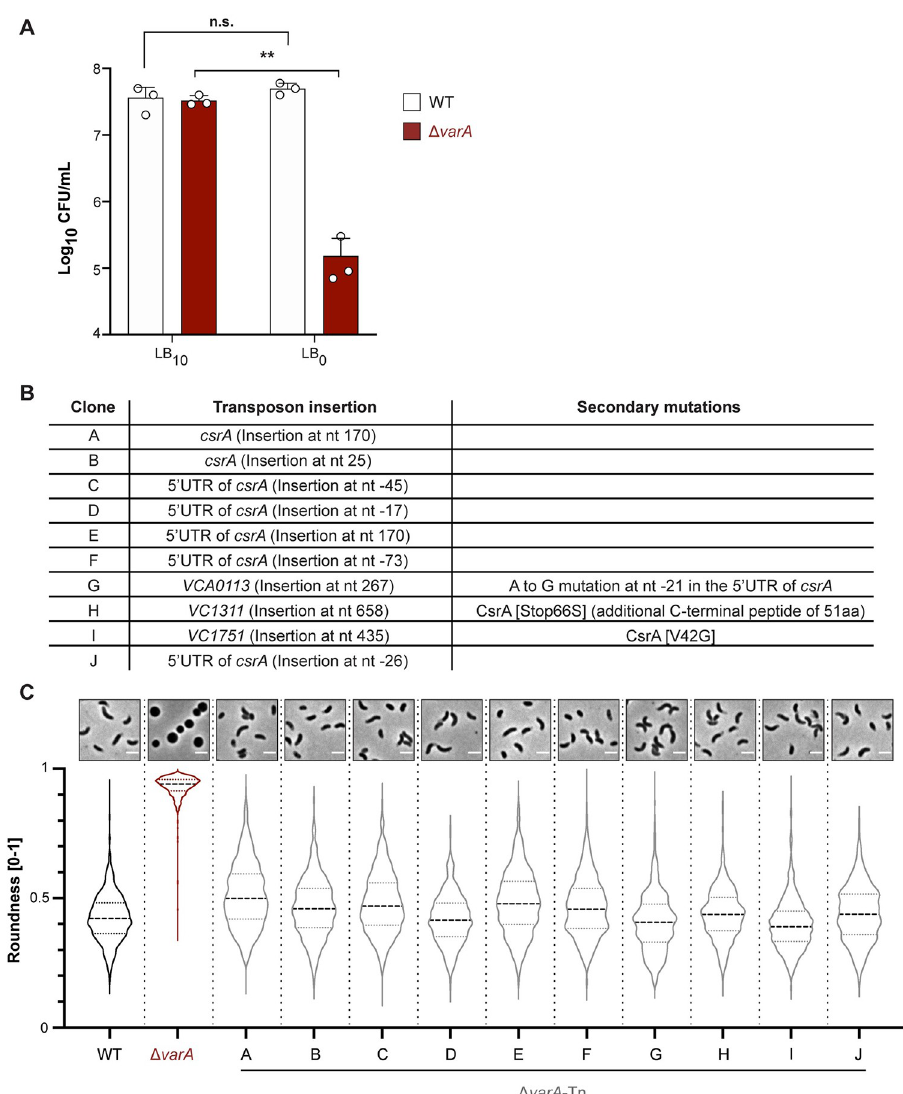
Fig 4. Suppressor mutants of Δ varA are linked to csrA . (A) Late growth Δ varA cells are sensitive to low osmolarity medium. After 20 h of growth, WT and Δ varA bacteria were diluted 1:100 in regular LB 10 or salt-free LB 0 medium for 1 h before further dilution and plating to enumerate CFUs on the next day. Bars represent the mean of three independent repeats; error bars show the standard deviation (S.D.) Log-transformed data were used for statistical analysis, which were based on unpaired t tests with Welch’s correction. �� , P < 0.01; n.s., not significant. (B) Summary of transposon hits. LB 0 -surviving mutants were isolated from the Δ varA -Tn transposon library, and the transposon insertion sites were determined. Information for 10 different mutants is provided. (C) Suppressor mutants restored the Vibrio cell shape. Phase contrast micrographs (top) and roundness quantification (bottom) of the WT, Δ varA , and the ten Δ varA -Tn suppressor mutants (A-J). Cells were imaged at 20 h post-dilution. Imaging details as in Fig 1. Scale bar: 2 μ